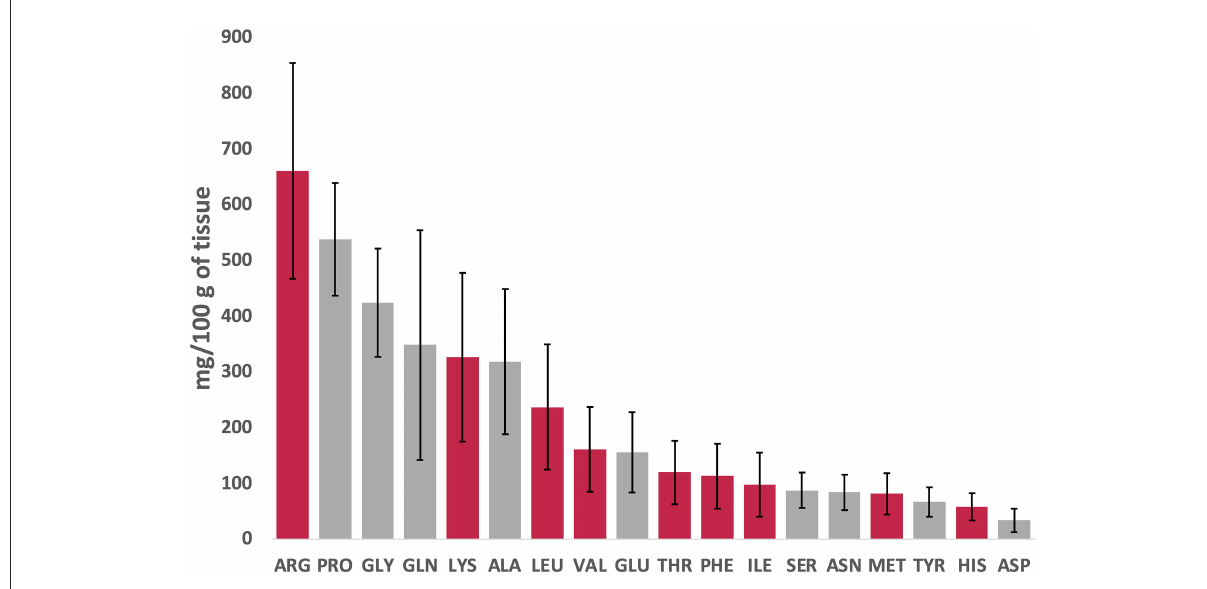
FIGURE2 Overview of free amino acids (FAAs) concentrations (essential, red; non-essential, gray) in DWRS arranged in decreasing order (left to right), regardless of the effect of storage time (12 months at − 18 ◦ C) or packaging method.